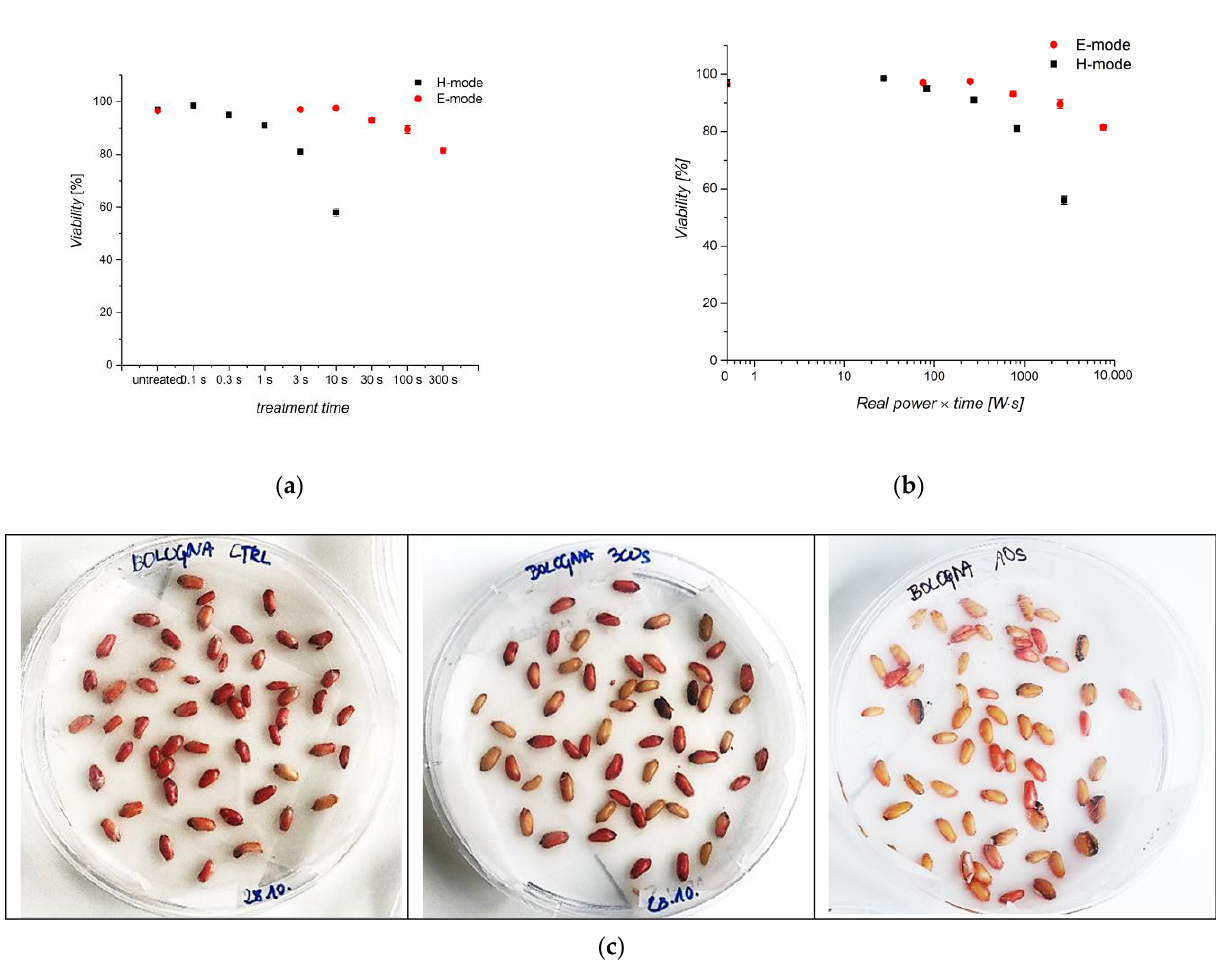
Figure 10. ( a ) Comparison of seed viability after treatment in E and H-mode plasma at different treatment times. ( b ) Correlation between seed viability versus real power and treatment time in plasma. ( c ) Results of the colorimetric assay with tetrazolium chloride. From left to right: untreated seeds; 300 s treatment in E-mode; 10 s treatment in H-mode. The error bars in ( a , b ) represent standard error mean values (±SE) for the respective duplicates given.